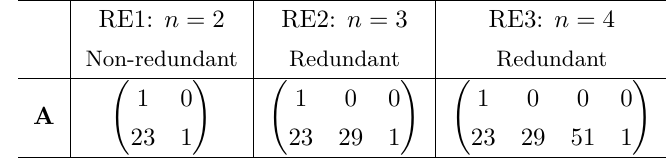
in redundant cases with k = 1 and m = 2 8